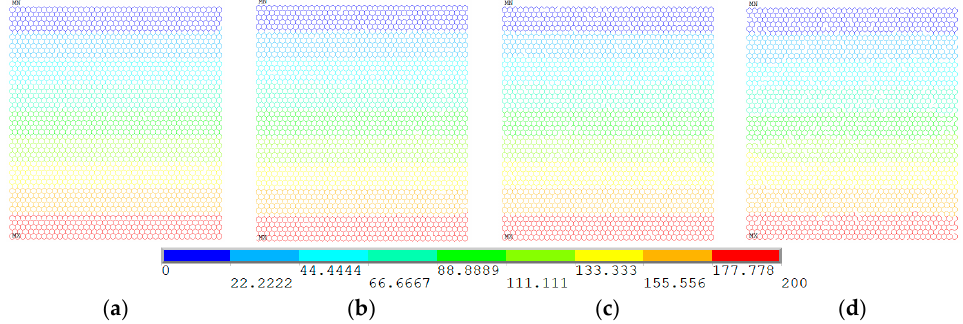
Figure 18. Temperature results of random vacancy defected graphene with its heat source in armchair edges (the percentages of vacancy defects in ( a – d ) are 0.2%, 0.5%, 1%, and 3%, respectively).